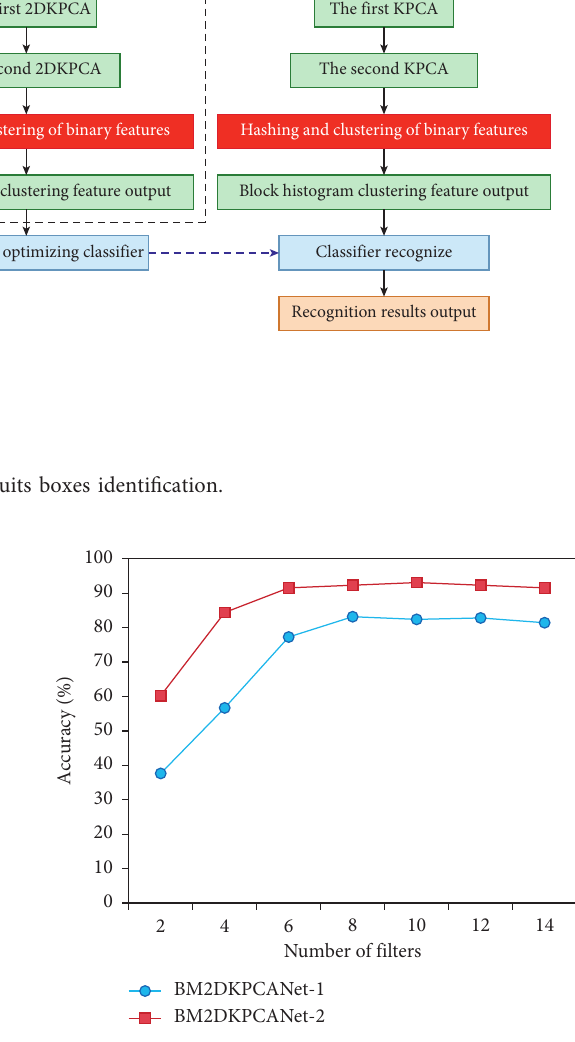
Figure 9: Boxes recognition accuracy with different number of